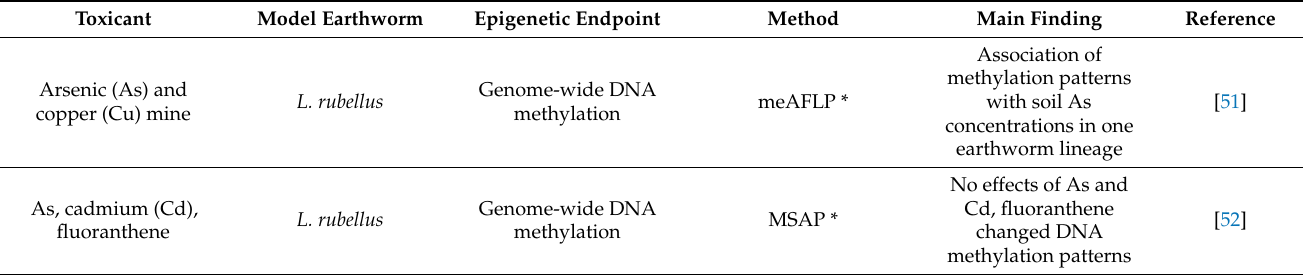
Table 1. Summary of the studies evaluating the effects of environmental pollution on